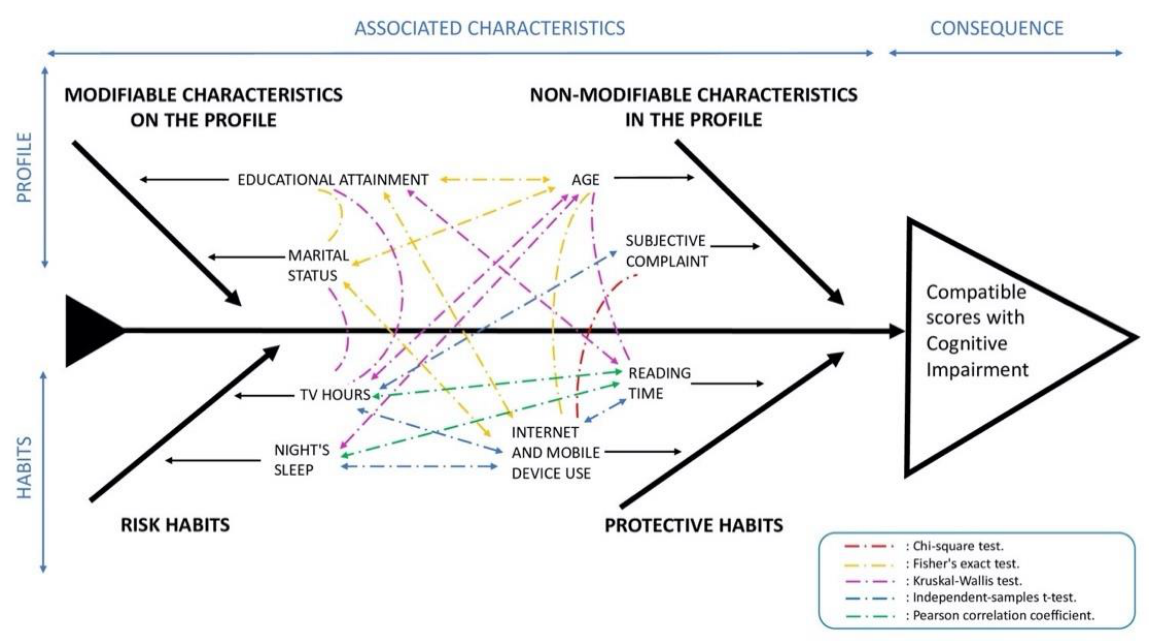
Figure 2. Characteristics associated with cognitive impairment scores (continuous arrows) and statistically significant associations between these characteristics (discontinuous arrows).